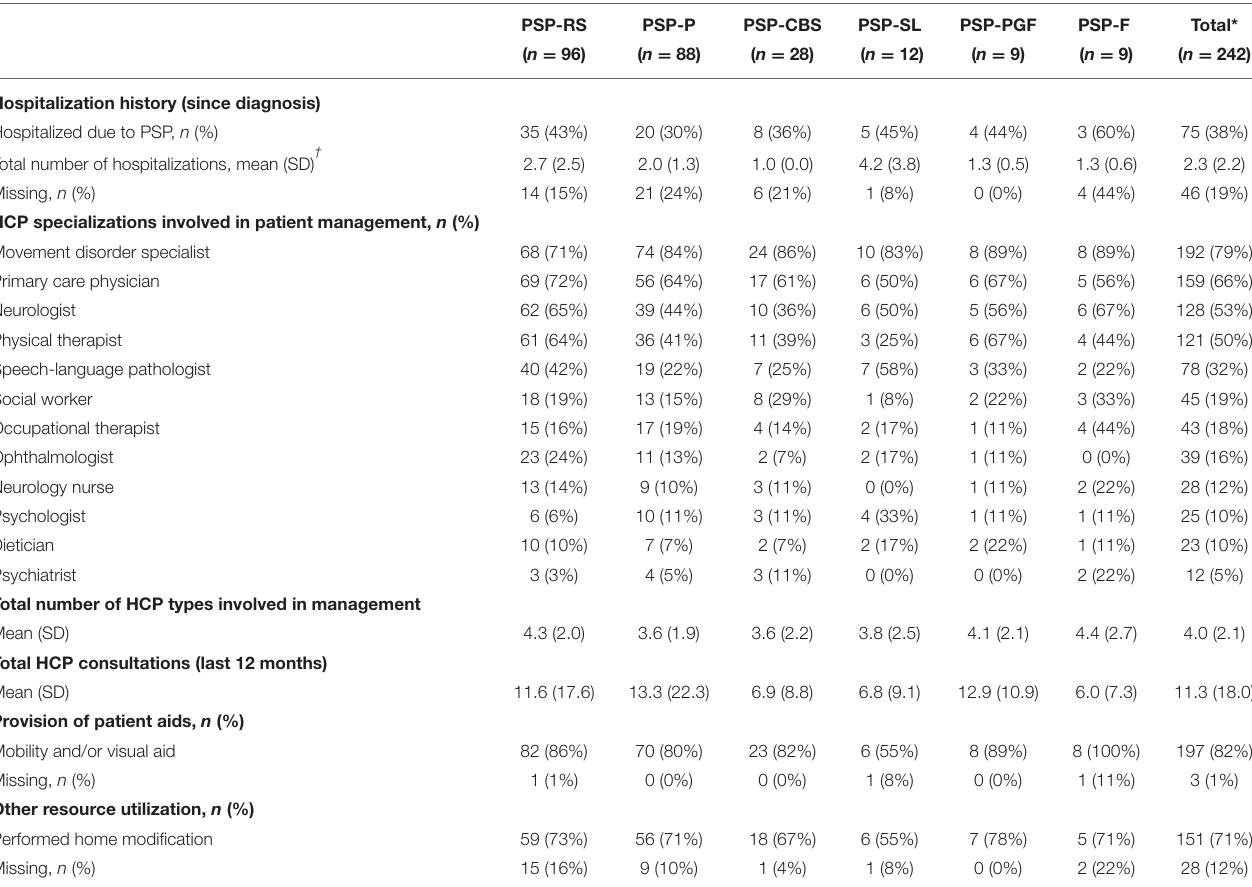
TABLE 4 | Burden on healthcare system, by PSP